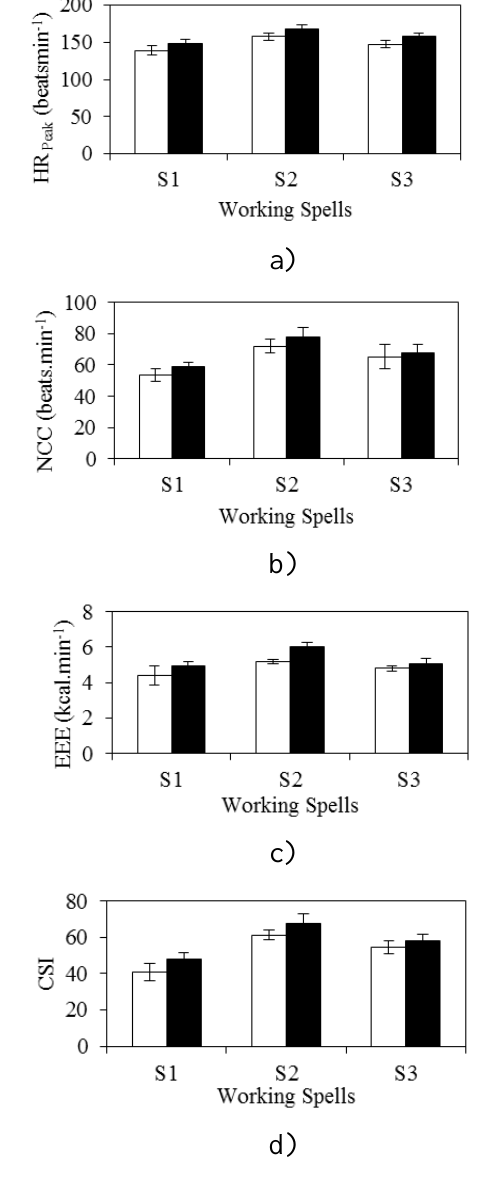
Figure 2. Comparison of cardiac